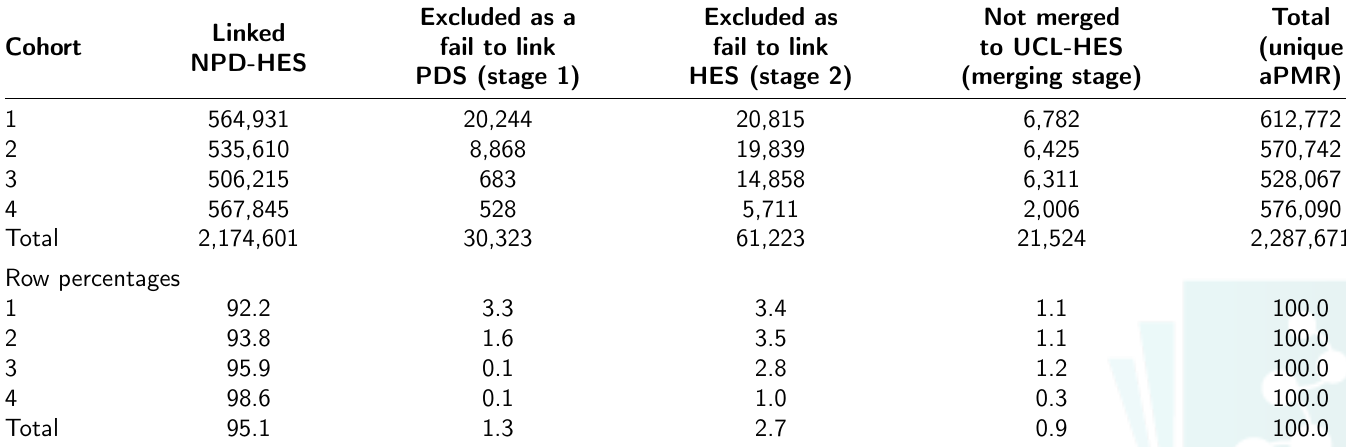
Supplementary Table 5.2: Pupils records by linkage stage (stages 1 and 2), merging stage and